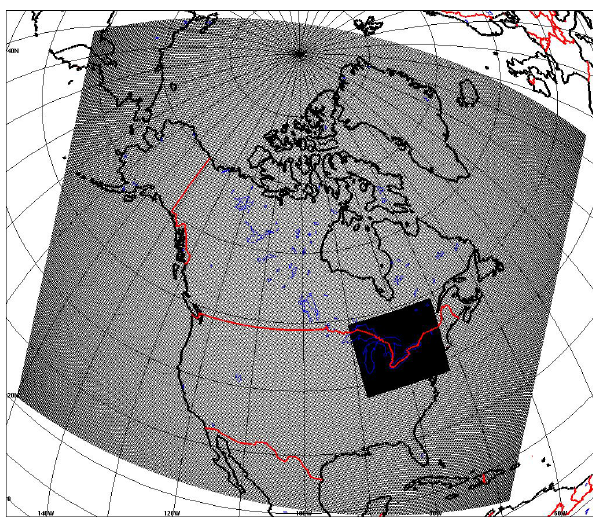
Fig. 1. GEM 15-km core domain and 2.5-km limited-area domain.